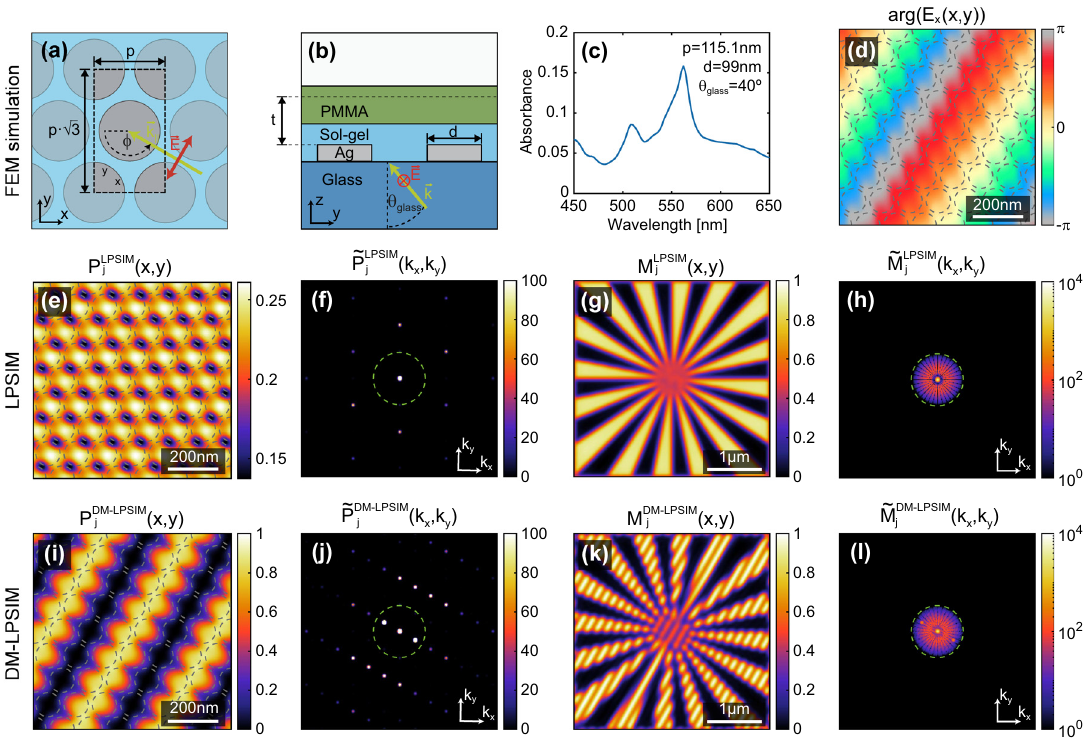
Figure 2: Simulation procedure. (a) Top view of the hexagonal array with the pitch p and the nanodisk diameter d . The dashed rectangle indicates the unit cell. (b) Side view of the system indicating the material composition of the sample stack and the incident s-polarized plane wave. (c) The absorbance spectrum of the hexagonal Ag array A 1 . (d) Phase pro fi le arg( E x ( x , y )) of 7 × 4 combined unit cells. (e,f) Example LPSIM illumination pattern and its Fourier transform. (g,h) A simulated LPSIM measurement and its Fourier transform. (i,j) Example DM-LPSIM illumination pattern and its Fourier transform.(k,l) A simulatedDM-LPSIMmeasurementand itsFouriertransform.The dashedcirclesin thepanels(d),(e) and(i) indicatethe size and positions of the nanodisks. The green dashed circles in the Fourier plots indicate the cutoff frequency of WF imaging. Panels (d – l) show results at an extraction height t = 40 nm andan azimuthal angle ϕ = 150 ° . The color scale in the panels(h) and(l) is logarithmic and otherwise